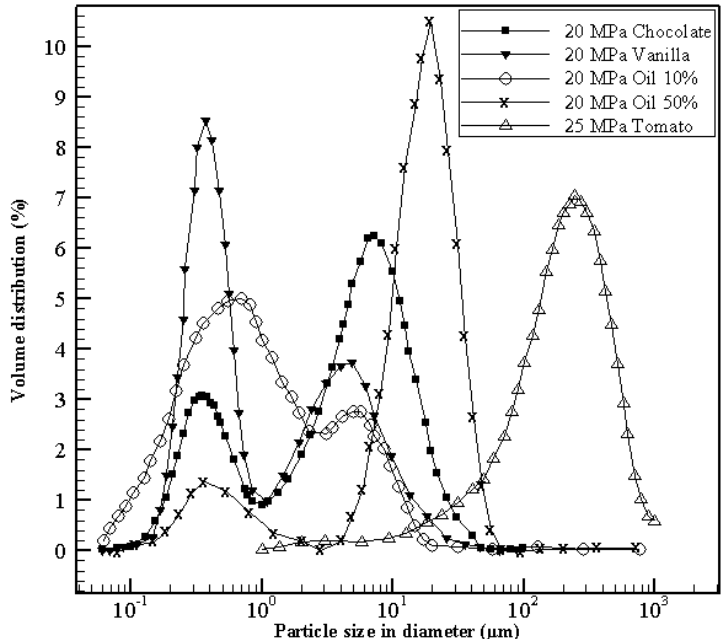
Figure 7: Effect of homogenizing pressure conditions of 20 MPa on droplet size distributions of 10% and 50% oil concentration of O/W emulsions, tomato based at 25 MPa, chocolate and vanilla based products at 20 MPa [5, 6, 11].